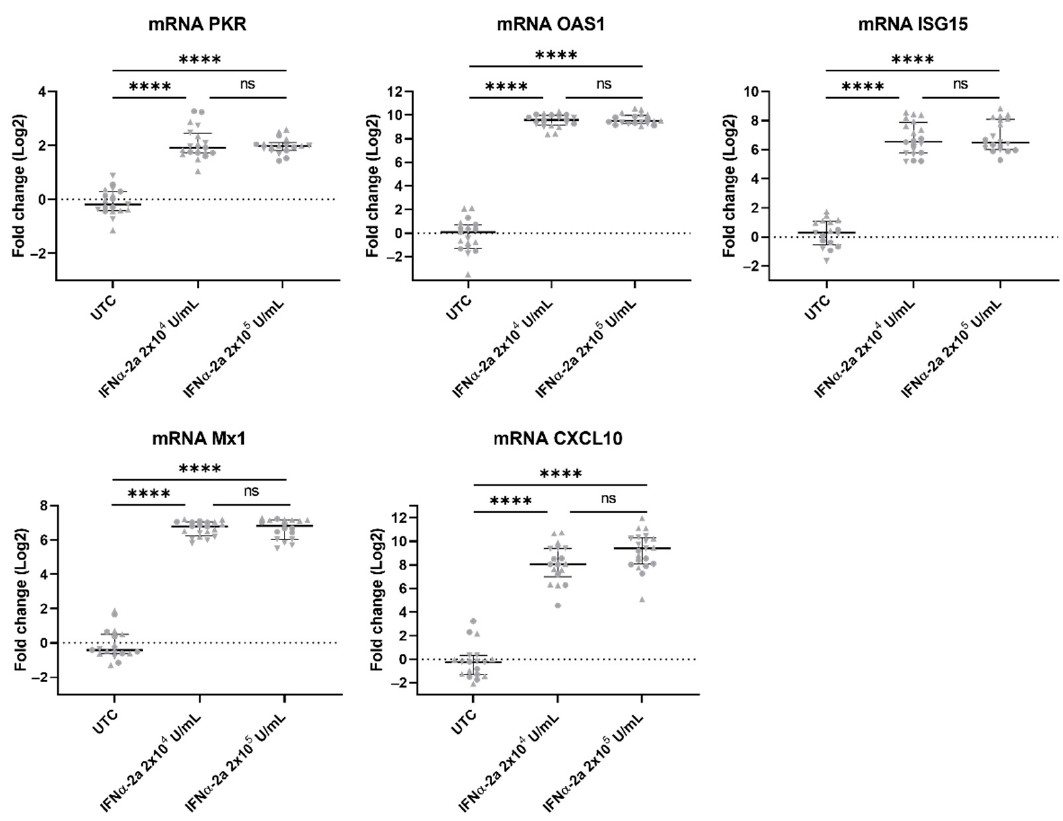
Figure 8. ISGs are upregulated in VZV-infected hiPSC neurons that are treated with IFN α . Neuronal cell body lysates were harvested at 7 dpi and analyzed by RTqPCR. Transcript expression (log2) was set out relative to the mean of the untreated control group (UTC), i.e., fold change. Each symbol represents the log2 fold change of a single culture originating from one of three independent biological repeats (Experiment 1: circles, PKR n = 7/7/6, OAS1 n = 7/7/7, ISG15 n = 6/7/7, Mx1 n = 7/7/7, CXCL10 n = 7/7/7; Experiment 2: triangles, PKR n = 7/8/7, OAS1 n = 8/8/8, ISG15 n = 7/8/7, Mx1 n = 8/8/6, CXCL10 n = 7/8/8; Experiment 3: upside down triangles, PKR n = 5/5/5, OAS1 n = 4/5/5, ISG15 n = 4/5/6, Mx1 n = 4/5/5, CXCL10 n = 5/3/6). Lines with whiskers indicate the median with interquartile range from the three independent experiments combined. The p values reported were obtained from a Linear Mixed Model that was adjusted for multiple testing using Tukey HSD all-pairwise comparison test. **** p < 0.0001. ns: not significant.